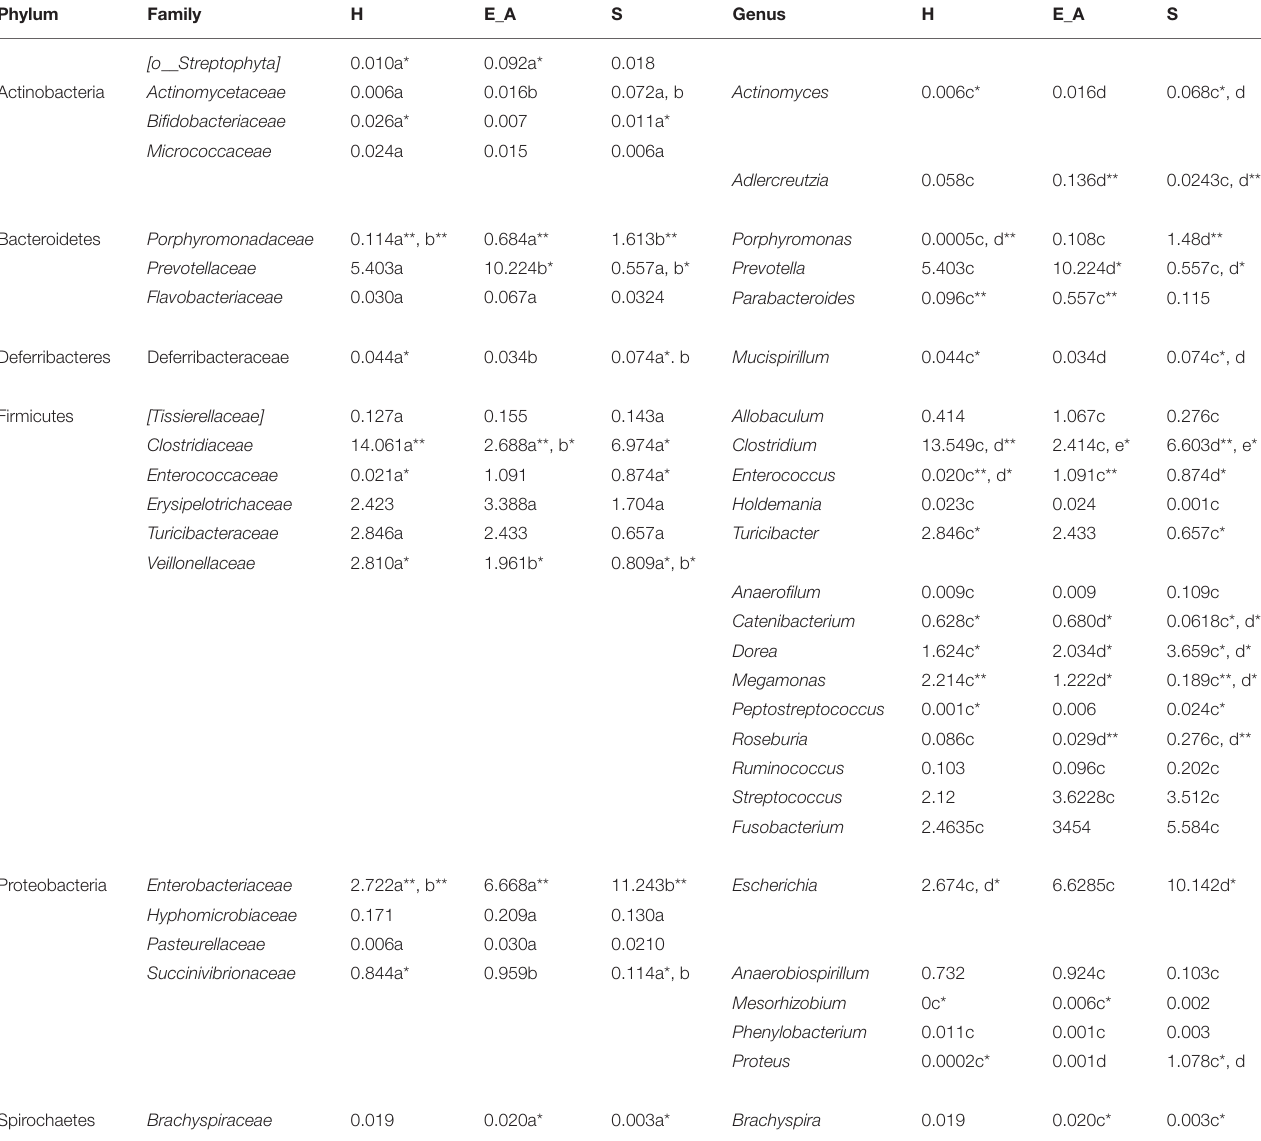
TABLE 5 | Relative abundances of the families and genus that resulted significantly different among the three